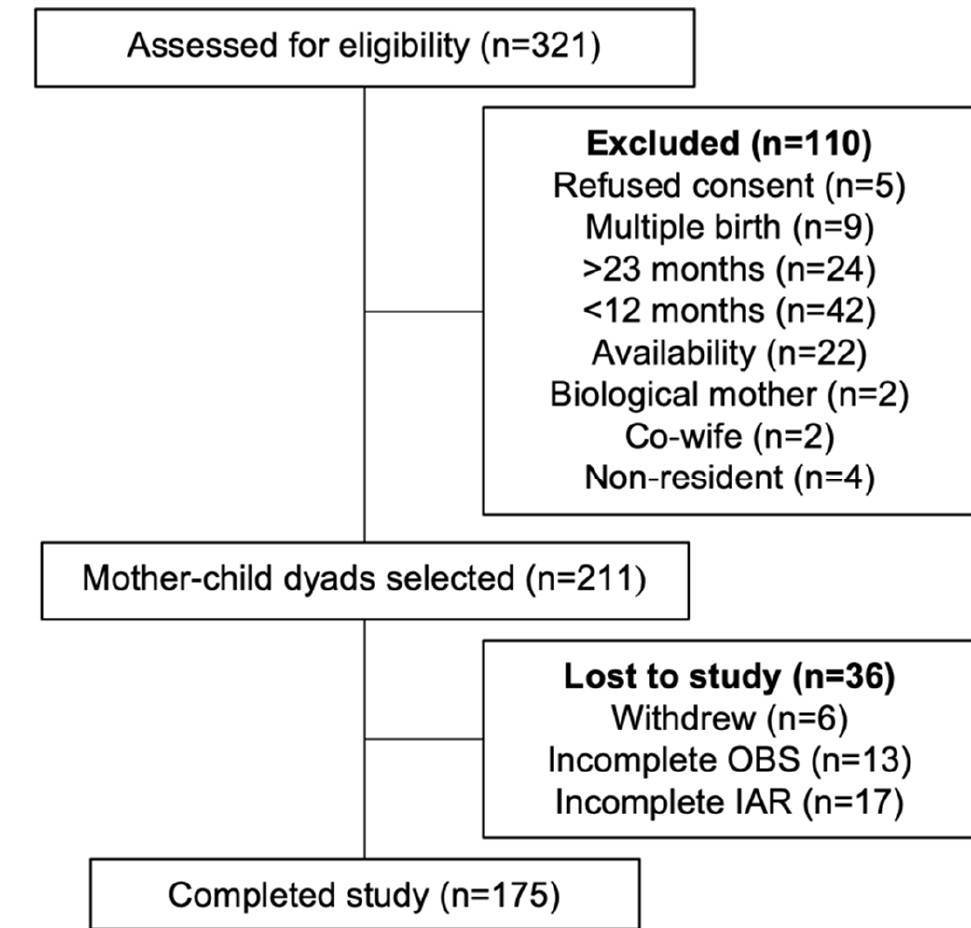
Figure 1. Study population. OBS, observation; IAR, image-assisted recall.